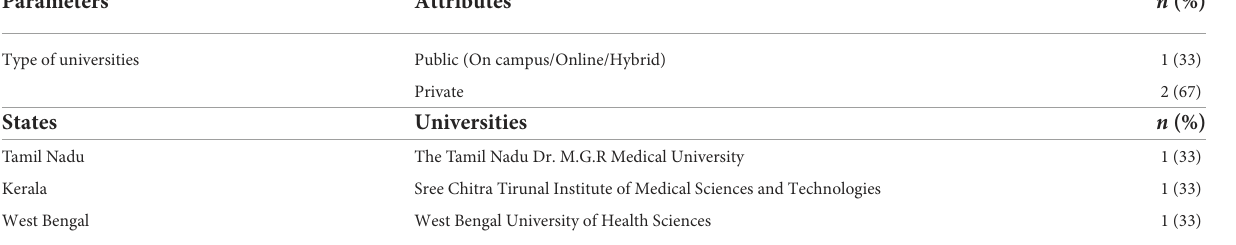
TABLE 7 Frequency of diploma programs provided by universities in the different states ( N = 3).